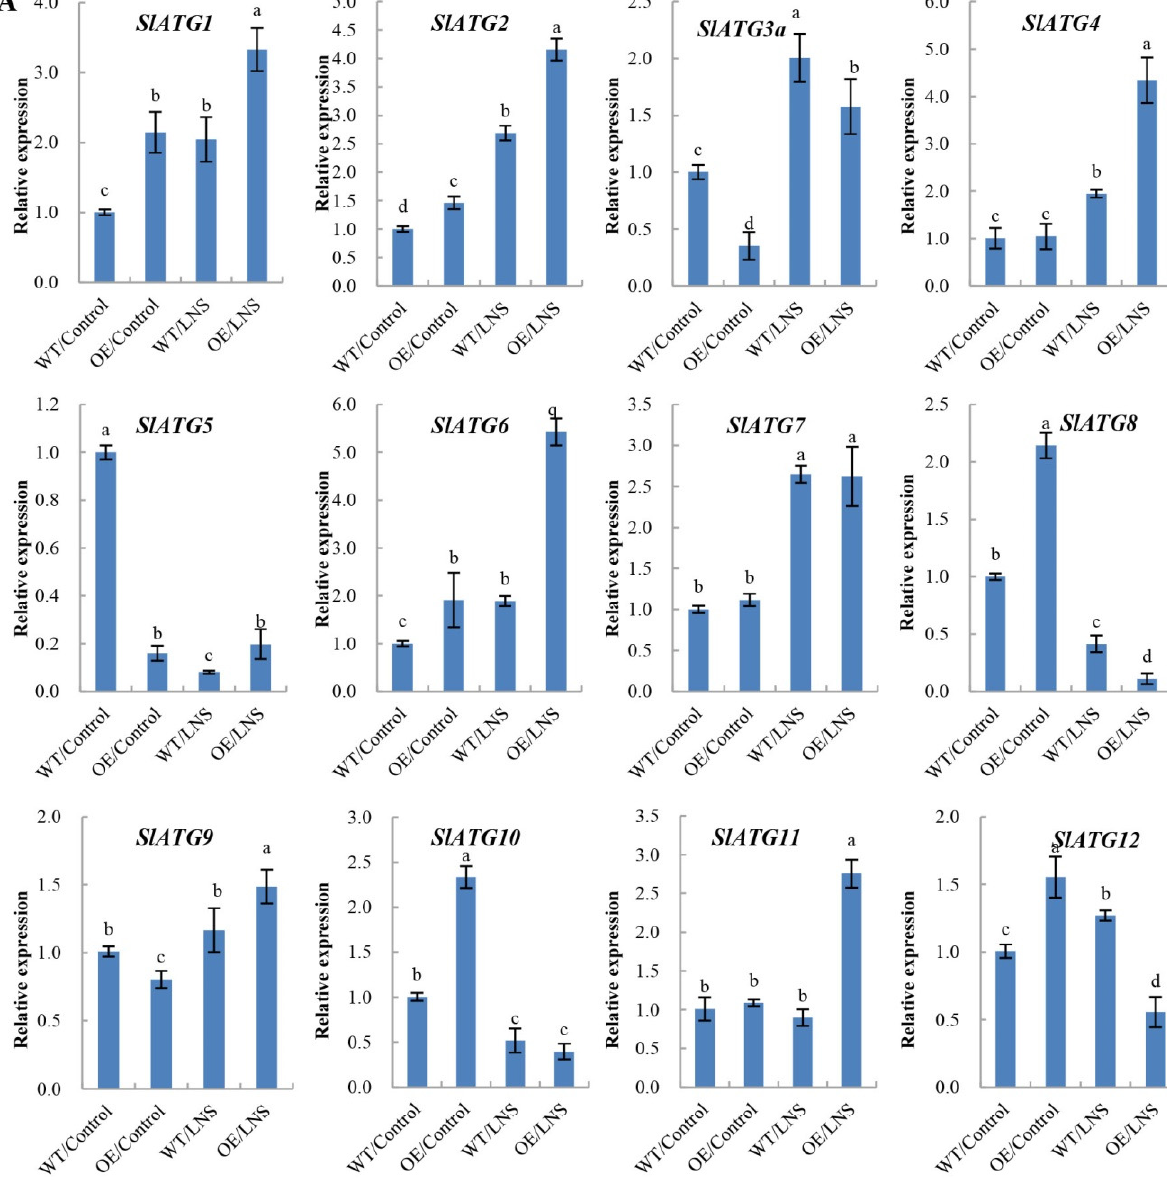
Figure 3. Effects of PpSnRK1 α overexpression on autophagy activity in WT and OE leaves under 7 days of LNS. ( A ) Changes in the transcription levels of tomato ATGs in the WT and OE lines. ( B ) Autophagosomes by MDC staining in leaves of WT and OE plants. Autophagosomes by MDC staining are shown as green signals. Bars: 50 μ m. ( C ) The number of autophagosomes by MDC